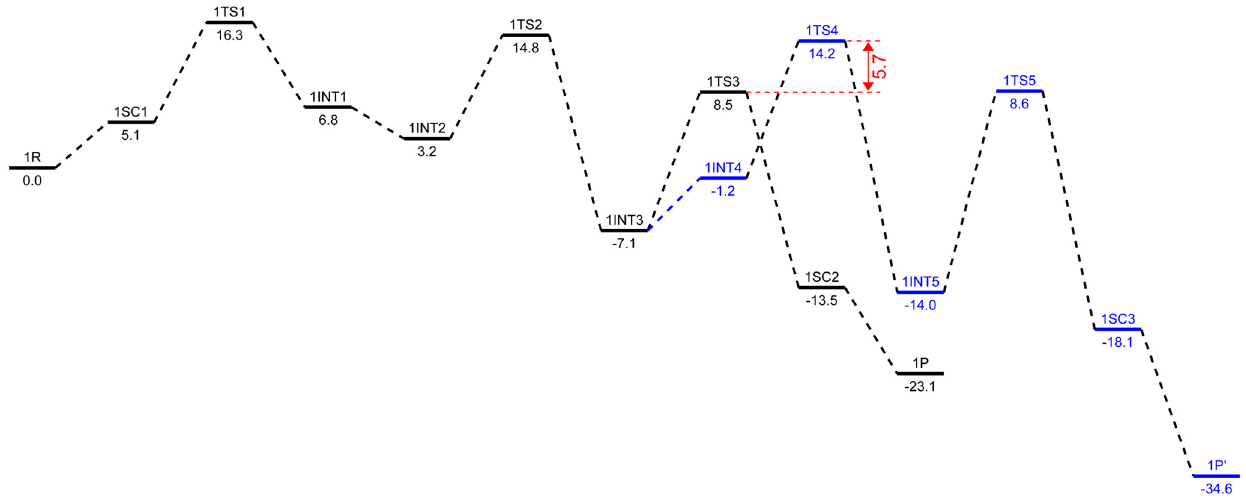
Figure 5. Corrected free energy pro fi les (in kcal/mol) at the level of B3LYP/6-311++G(d,p) with GD3BJ for ethylene trimerization in black and tetramerization in blue, using the ortho -methoxyaryl Cr-PNP catalyst. The SMD polarizable continuum solvent model was used for solvent e ff ect correc- tion.